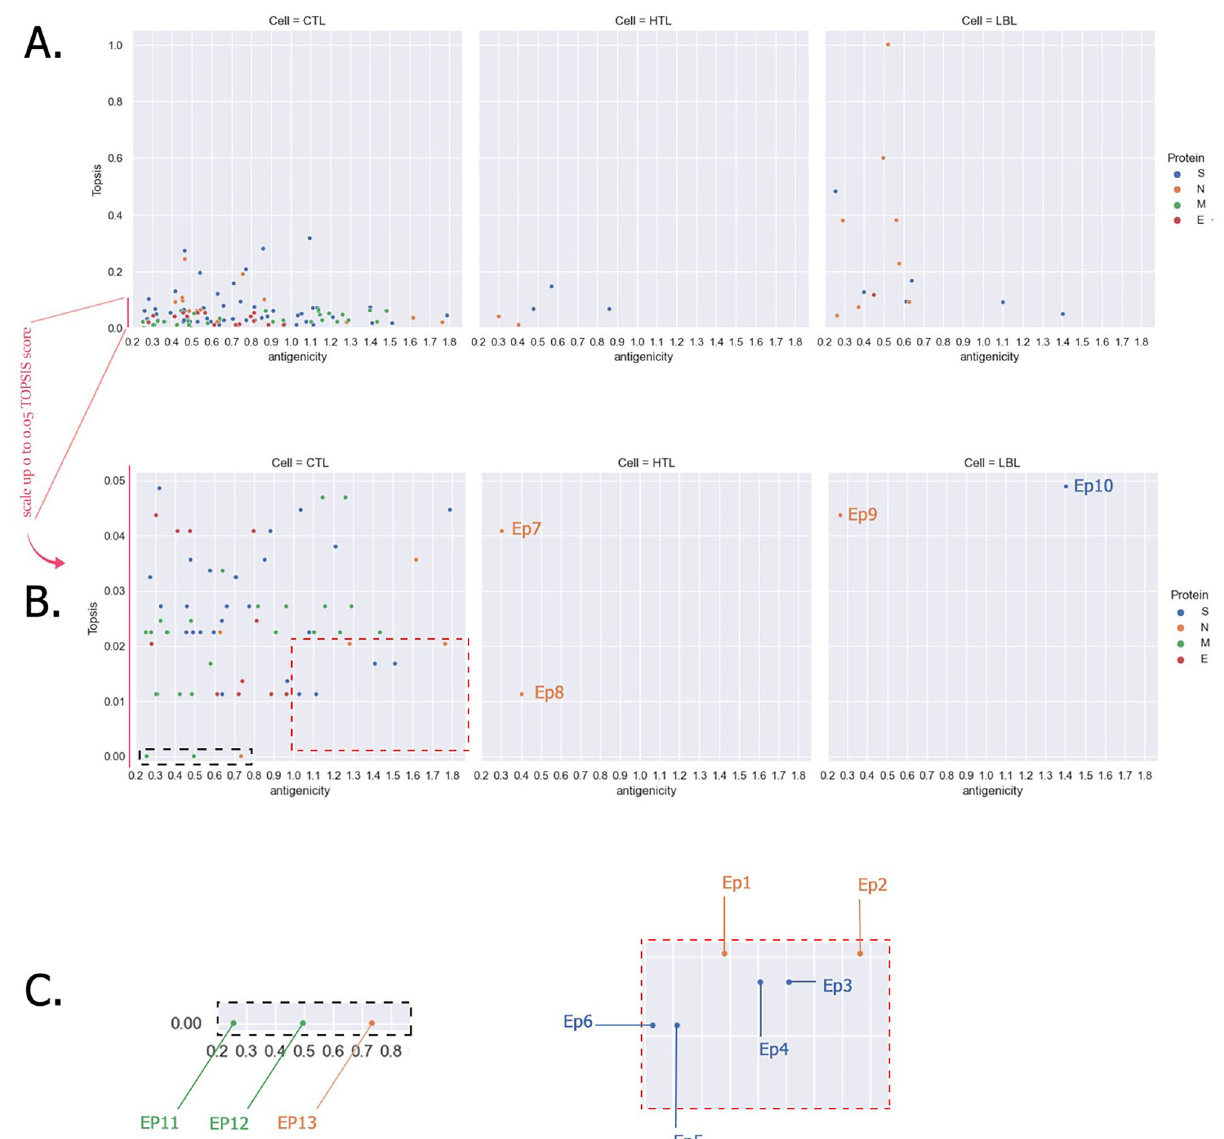
Figure 8. ASTP of epitopes from two perspectives. In Panel ( A ) predicted epitopes goes through a logical comparison due to TOPSIS score (vertical axis) and antigenicity (horizontal axis). This helps to differentiate between predicted epitopes with the same number of events but a distinct number of mutated sites. Again, right lower quadrant presents epitopes with higher immunologic properties besides higher conservity. Panel ( B ) scales up vertical axis (TOPSIS score) for better illustration of position of different dots (CTL, HTL, and LBL) in ASTP. The red and black boxes in CTL panel and EP7-EP10 of HTL and LBL epitopes are the most conserved ones with higher antigenicity. In panel ( C ) CTL epitopes boxes are magnified and ID of each epitope (dot) is noted. Sequence of each epitope is available in Sup. Table